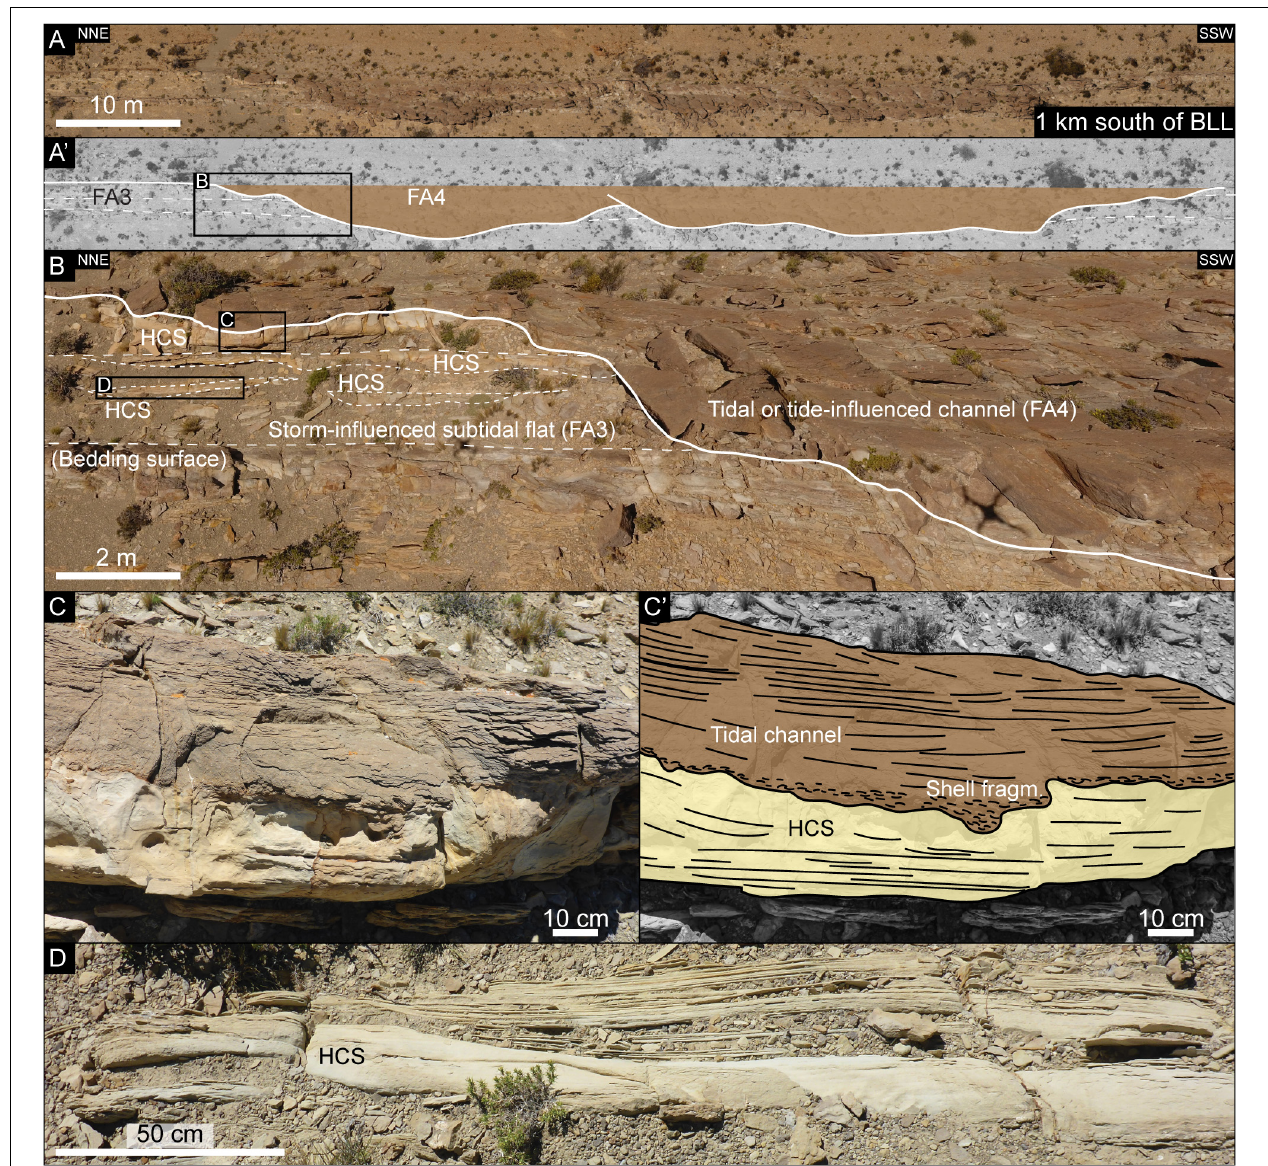
FIGURE 7 | Overview of FA4 deposits 1 km south of Barranca Los Loros (BLL) ( Figure 1D ); figure location indicated in Figure 9 . (A) Orthorectified overview photograph of FA3-FA4 interval. (A’) Overlay interpretation of A with FA4 tidal channels indicated in brown. (B) Close-up orthorectified photograph showing cutting relation of tidal channel (FA4) into storm-influenced subtidal flat deposits (FA3). Dotted white line indicates bedding surfaces of FA3. (C) Close-up of sharp erosional contact between FA4 and FA3, with (C’) overlay interpretation, HCS (Facies G). (D) Close-up view of HCS (Facies G) within FA3